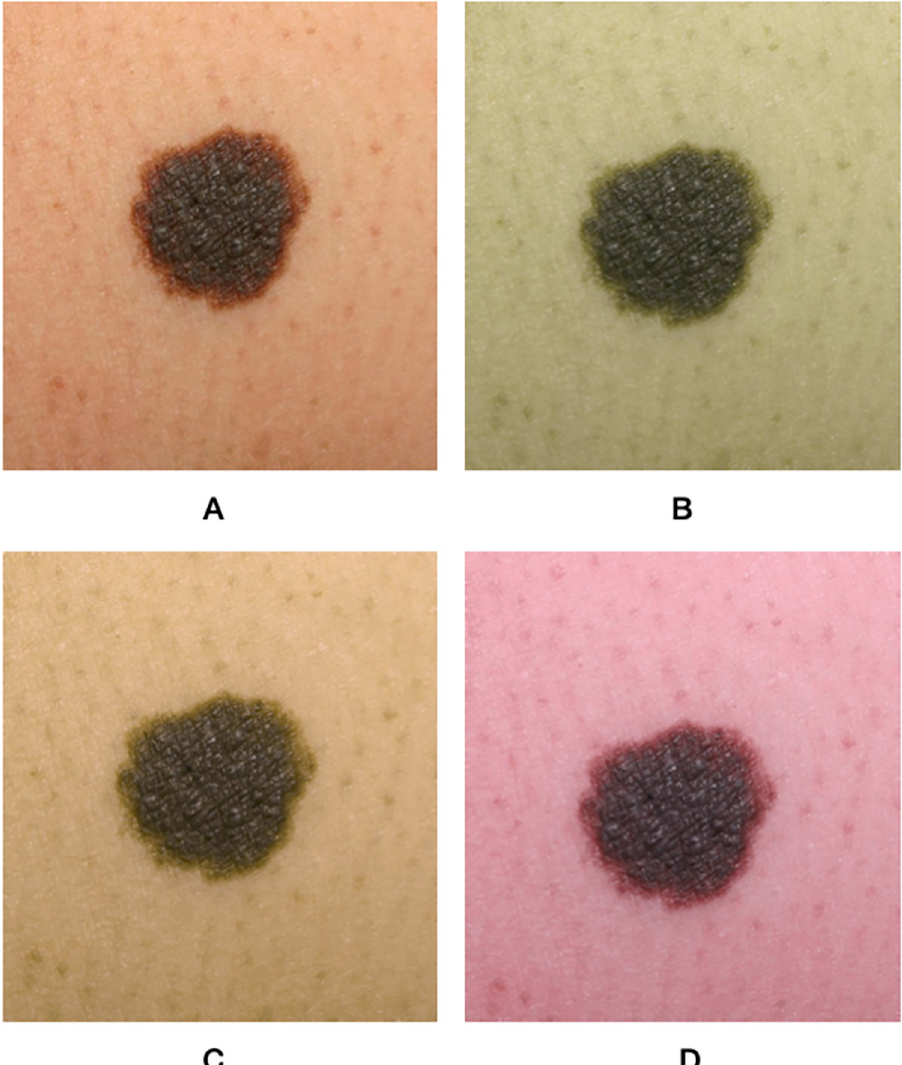
Fig 1. A nevus presented as an example of a benign skin lesion (A) simulated into what a protanope (B), deuteranope (C), and tritanope (D) participant would see. Note that the simulation included the lesion and the background skin, affecting the distinction at lesion borders. The image presented here is not a part of the MED-NODE